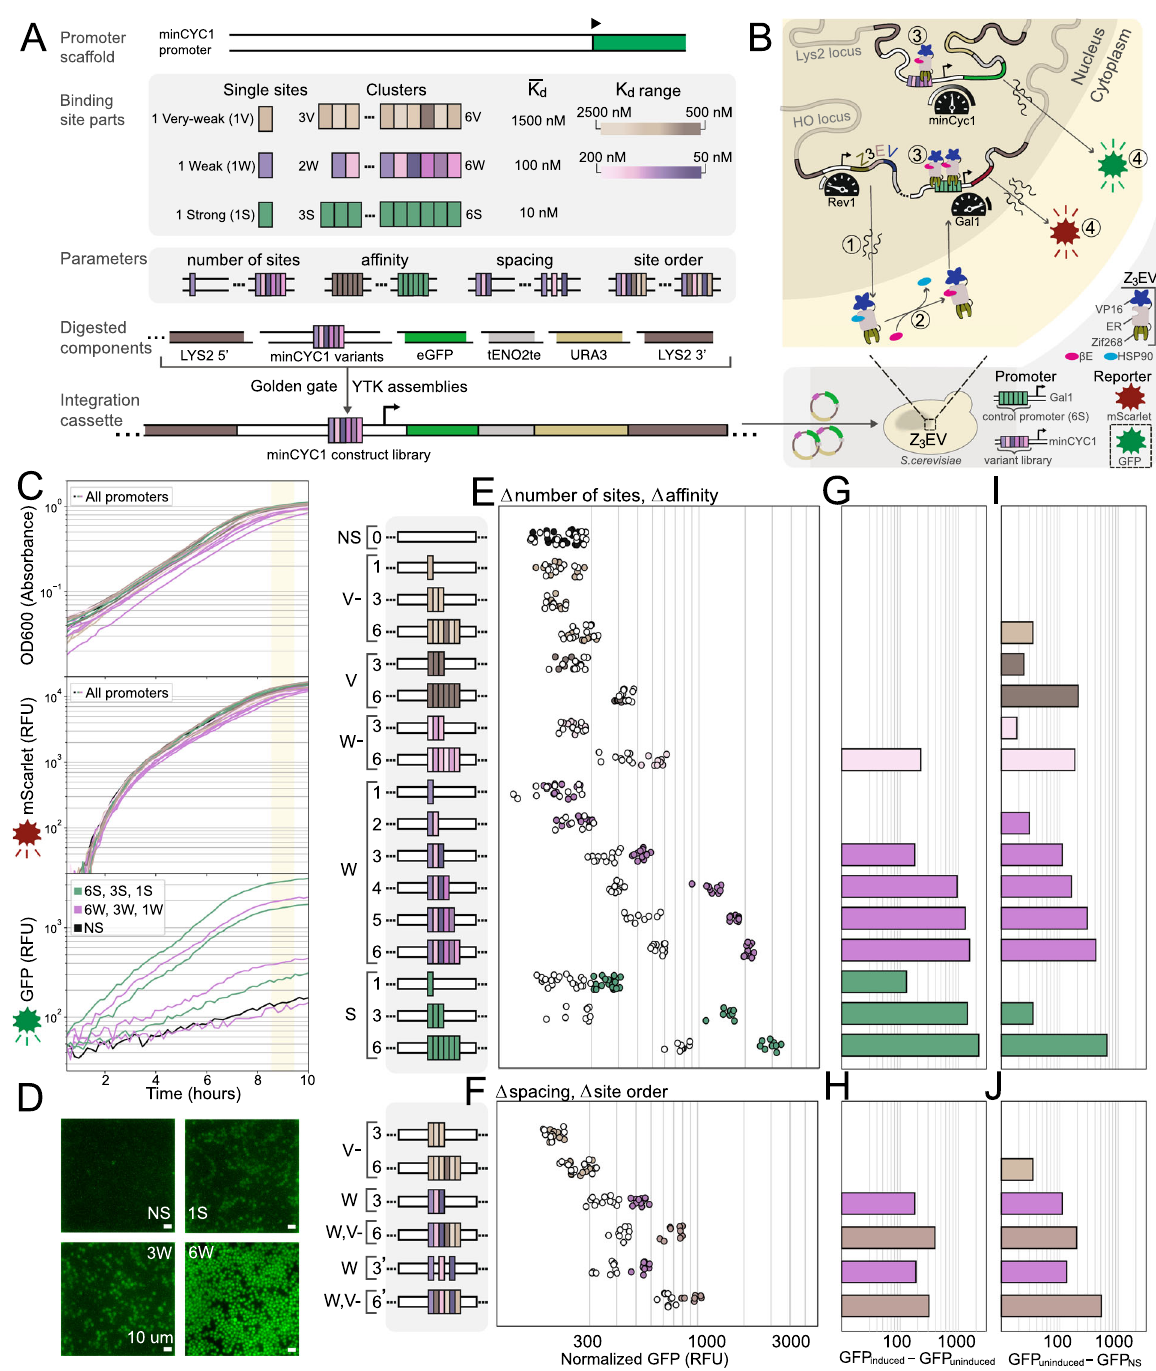
Fig.5|Invivocharacterizationinasynthetic,minimalgeneregulatorysystem. A Promoter legend. In vitro characterized Zif268 binding regions were inserted into